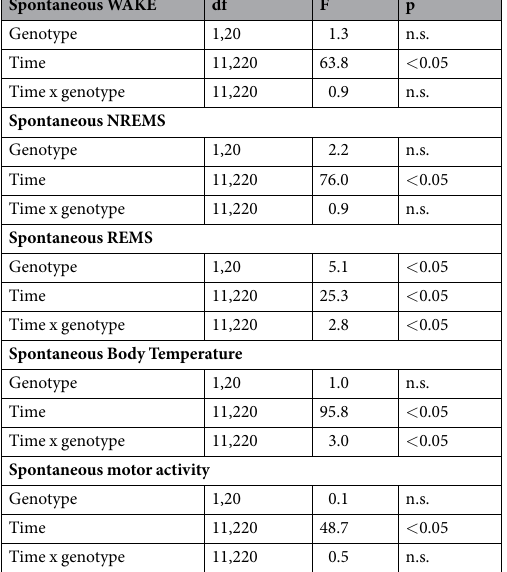
Table 1). The amounts of wakefulness and NREMS were similar between the two genotypes. IL-4R α KO mice had significantly more REMS during the light phase when compared to controls. This difference was due to a signifi- cantly higher number of REMS episodes observed in the KO mice when compared with control mice (25.3 ± 1.7 episodes in the Balb/c mice vs. 35.8 ± 3.1 episodes in the IL-4R α KO mice, p < 0.05). There was no significant dif- ference in the REMS episode durations between the two genotypes (78.2 ± 2.2 s in the Balb/c mice vs. 77.7 ± 1.8 s in IL-4R α KO mice).